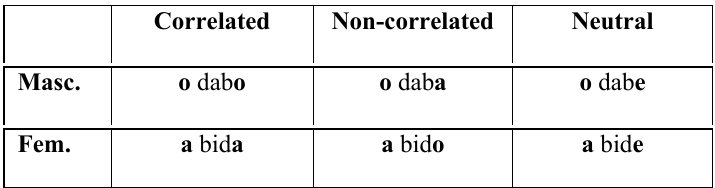
Table II: Examples of the linguistic stimuli in each condition